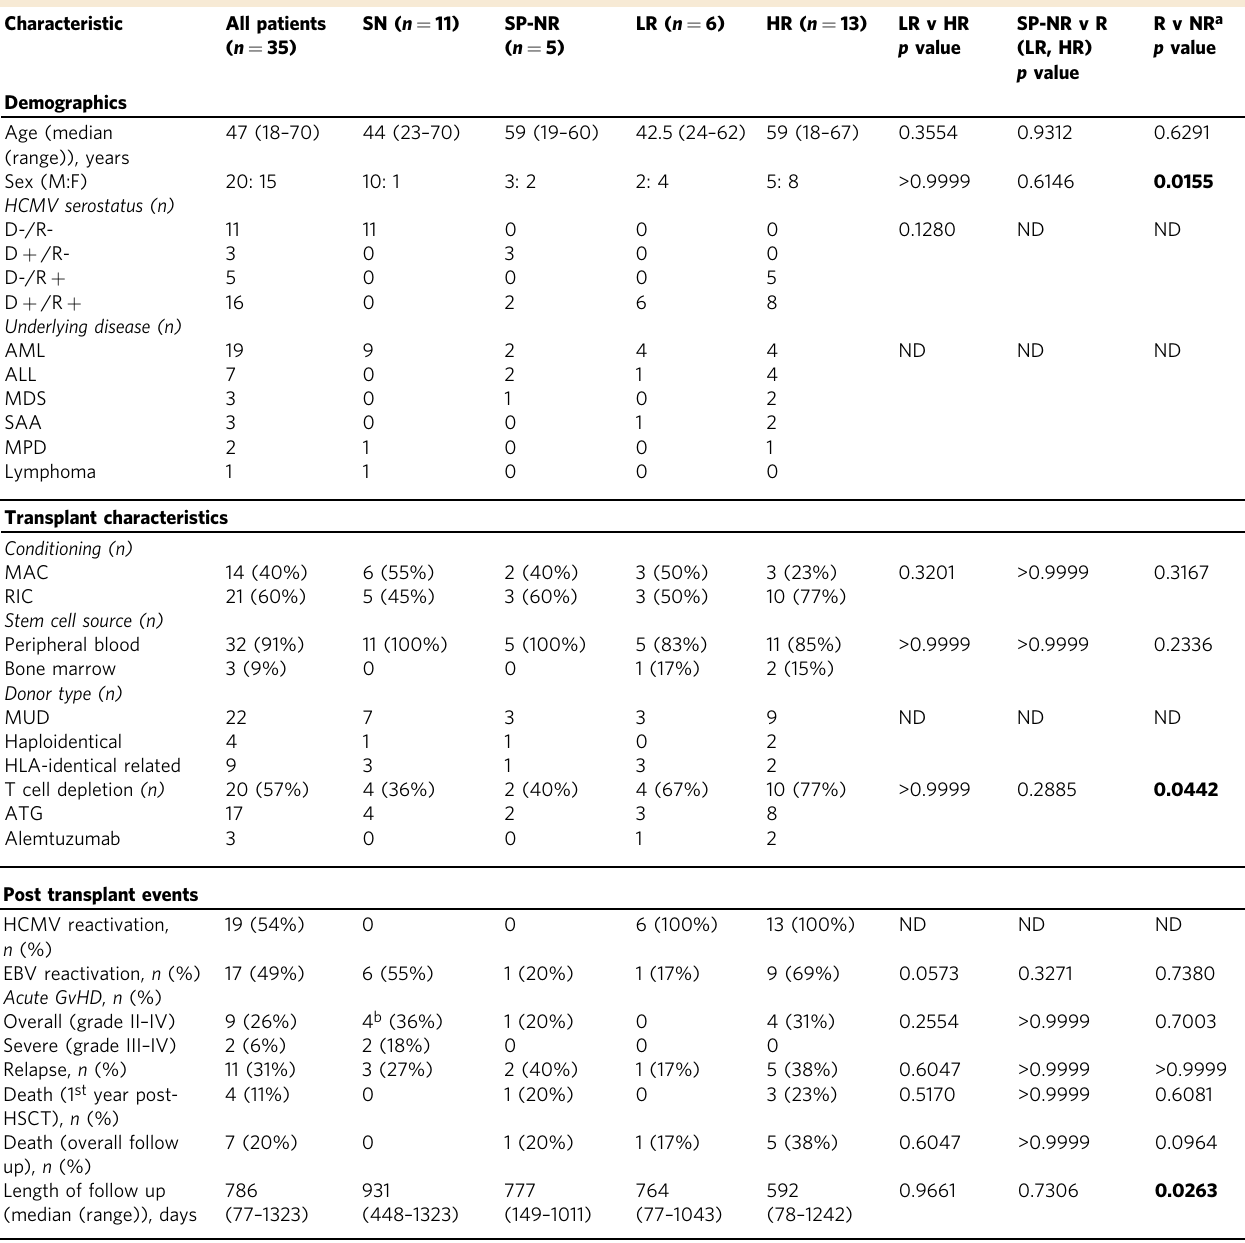
Table 1 Characteristics of study